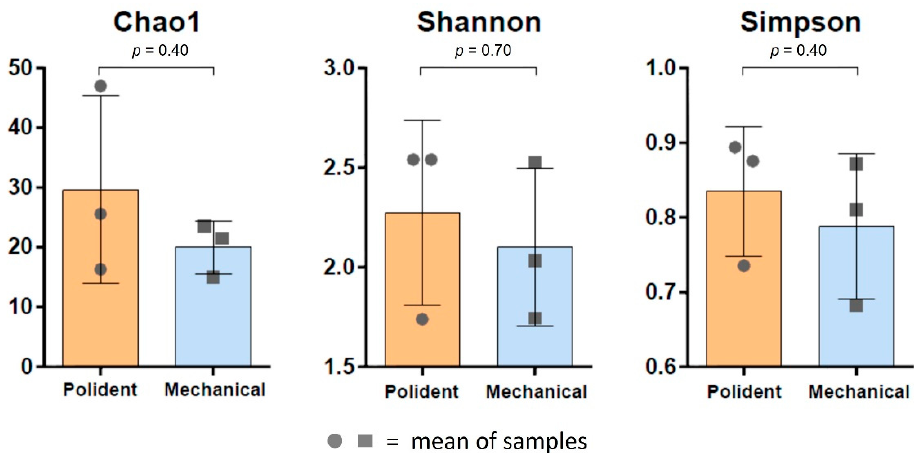
Figure 6. Beta diversity compared between before and after cleaning the acrylic retainers.